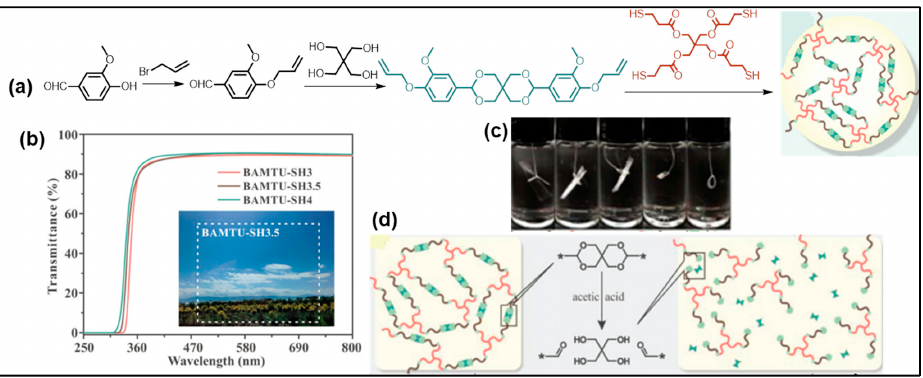
Figure 9. ( a ) Synthesis way of acetal bond-containing vanillin vitrimer; transparency ( b ), degradability ( c ) and its mechanism ( d ) of acetal bond-containing cured vitrimer [reproduced with permission from Ge et al.; published by RSC, 2021] [74].